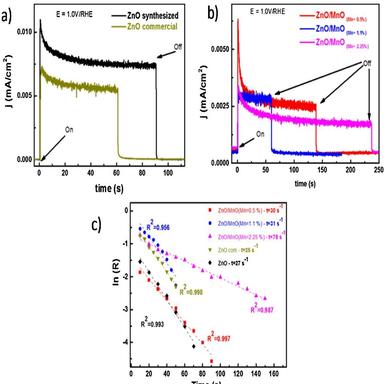
Chronoamperometric (1.0 V/RHE) responses of a) commercial ZnO and synthesized ZnO, b) n- ZnO/ p-MnO (Mn = 0.5%, 1.1% and 2.25%) nanocomposites when UV–vis light was irradiated (on) and interrupted (off), c) comparison of transient times constants of all materials.